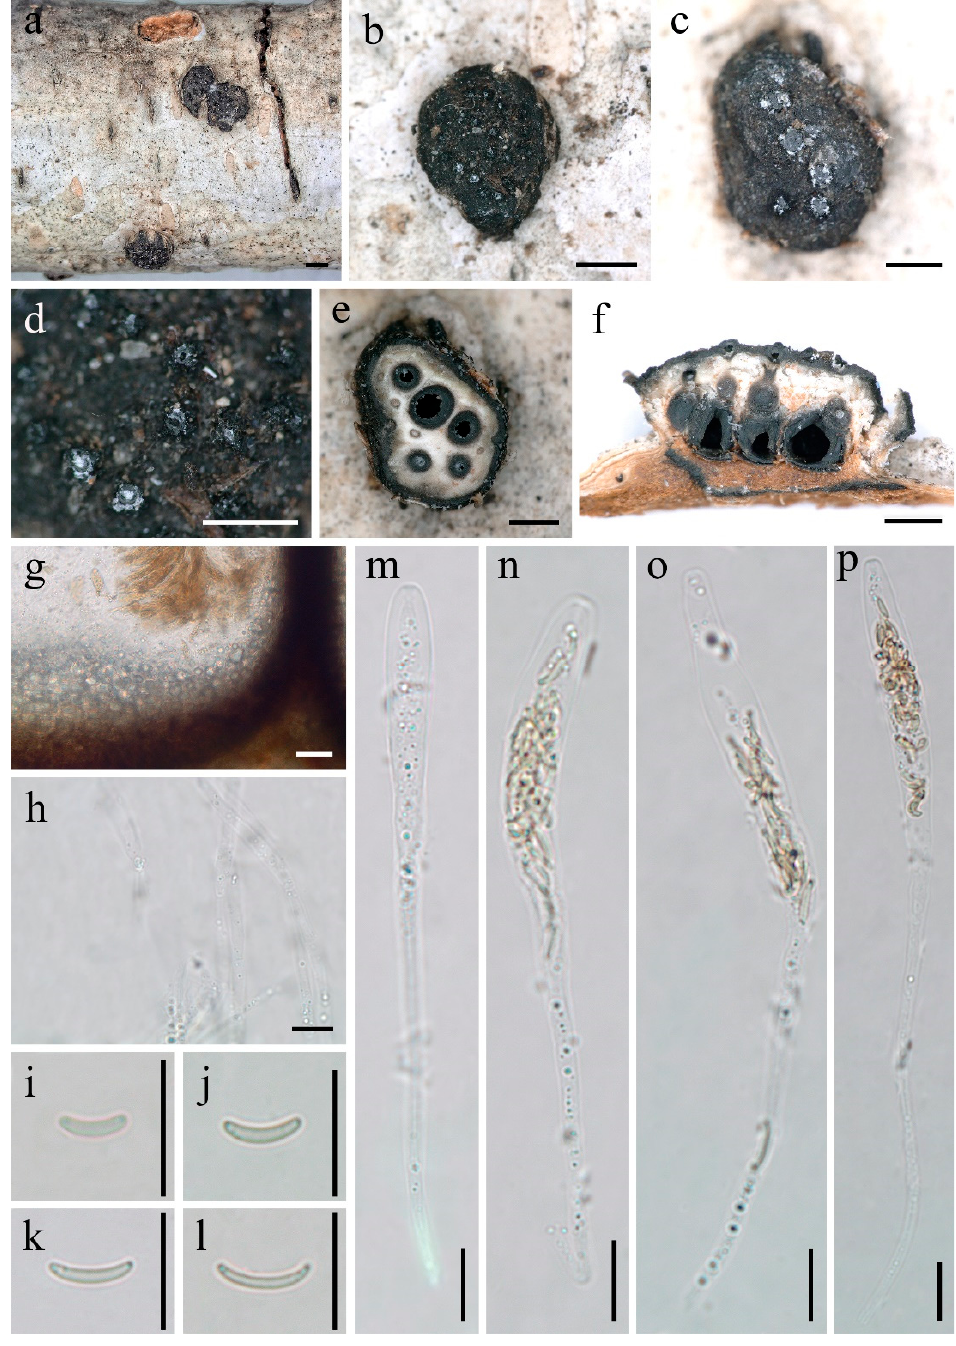
Figure 2. Diatrype betulaceicola (FCATAS 2725, Holotype). ( a – d ) Stromata on substrate; ( e ) cross section of a stroma; ( f , g ) vertical section through stroma showing ostiole and perithecia; ( h ) paraphyses in water; ( i – l ) ascospore in water; ( m – p ) ascus in water; scale bars (( a , b ) = 1 mm; ( c – f ) = 500 µ m; ( g – p ) = 10 µ m).